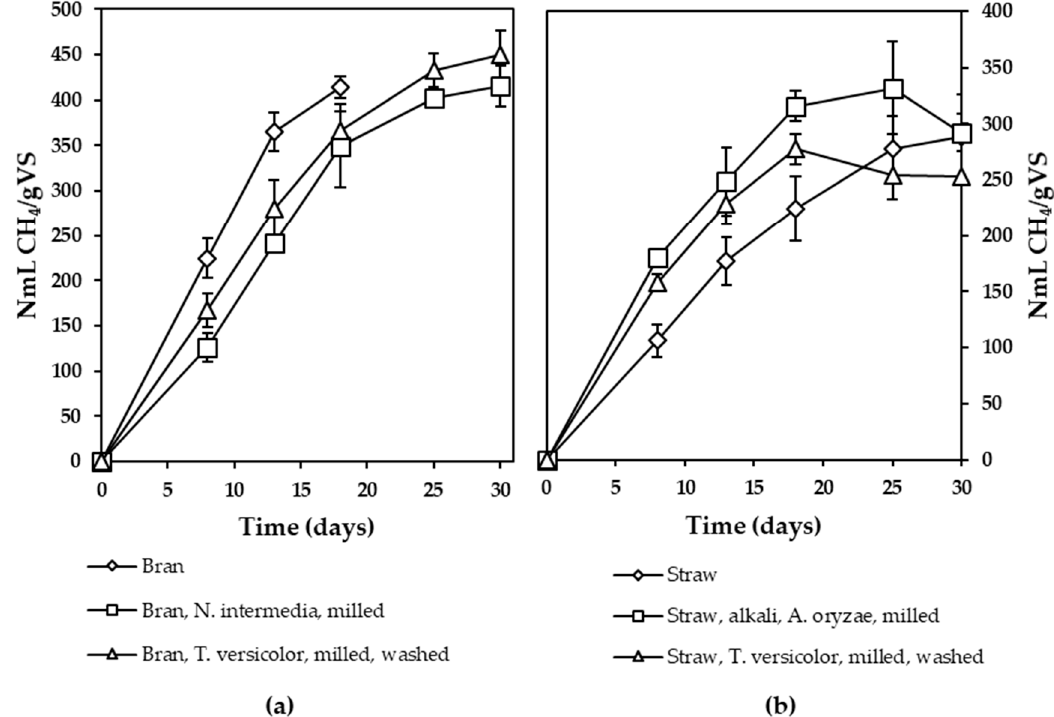
Figure 4. Cumulative methane production during the anaerobic digestion of the bio-based materials made of ( a ) bran and ( b ) straw.